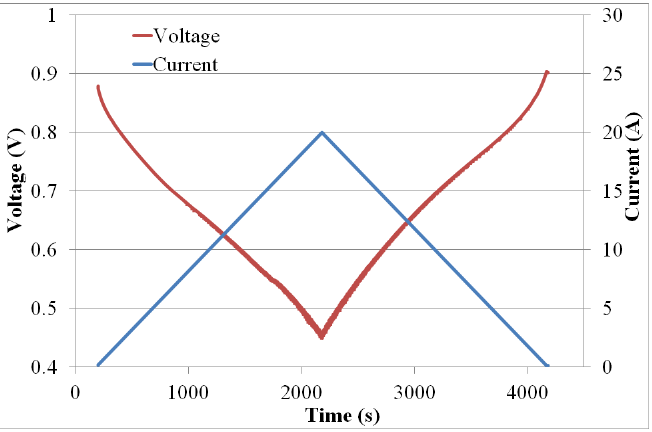
Figure 5. Experimental current and voltage of PEMFC for forward/backward sweep.